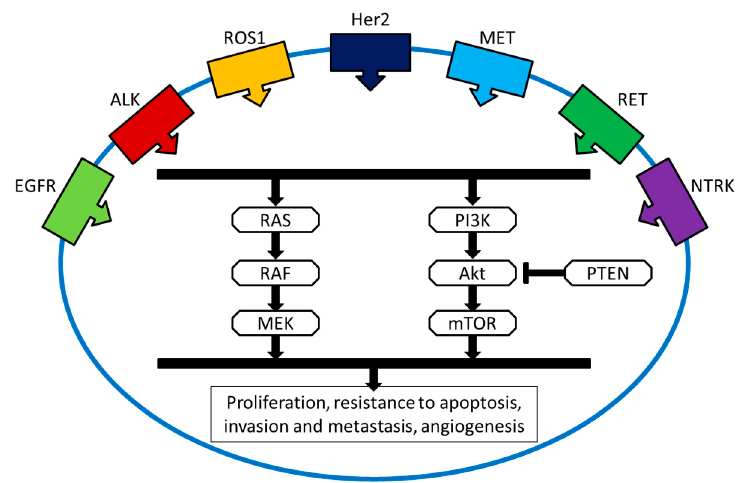
Figure 1. Targetable genes and main pathways that lead to cellular proliferation.